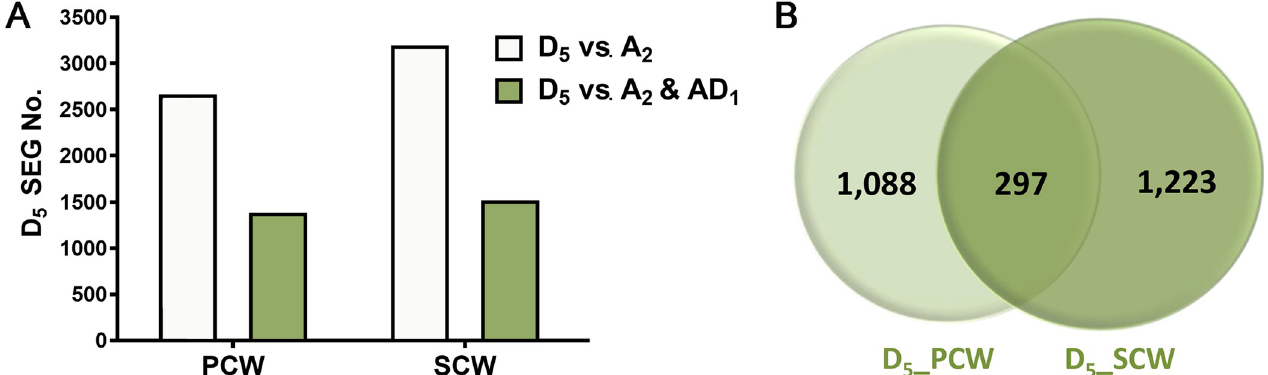
Fig 6. Transcriptomic analyses of wild diploid G . raimondii and two cultivated cotton species (1 st set). A. Quantification of specifically expressed genes (SEGs) in developing G . raimondii fibers at primary or secondary cell wall (PCW or SCW) stages by comparing them with G . arboreum (D 5 vs A 2 ) as well as G . arboreum and G . hirsutum (D 5 vs A 2 & AD 1 ). B. Venn diagrams representing the common SEGs in G . raimondii fibers between PCW (D 5 _PCW) and SCW (D 5 _SCW) stages.